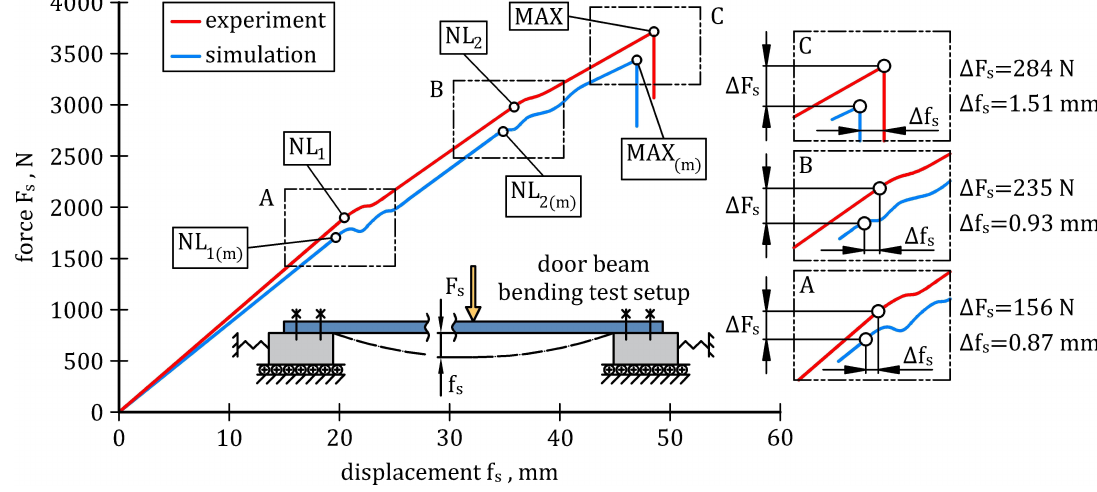
Figure 10: Comparison of the experimental curve of door beam bending with the computational curve for the mesoscale model.